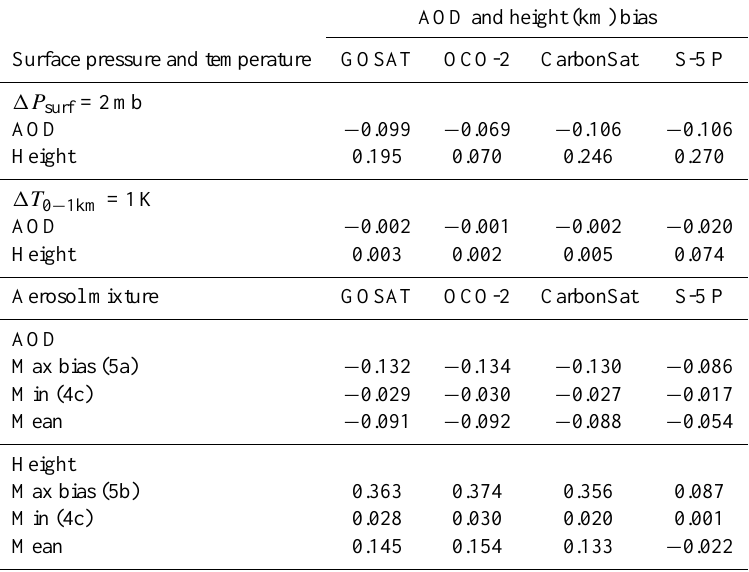
Table 4. Biases in retrieved AOD and height (in km) due to a surface pressure bias ( (cid:49)P surf ) of 2mb, a temperature bias ( (cid:49)T 0 − 1km ) of 1K for the altitude range of 0–1km and assumptions in aerosol mixture. The aerosol mixtures are given in parentheses using the nomenclature from Kahn et al. (2001). The reference aerosol mixture used in the simulations is mixture 2b. AOD and height (km) bias Surface pressure and temperature GOSAT OCO-2 (cid:49)P surf =